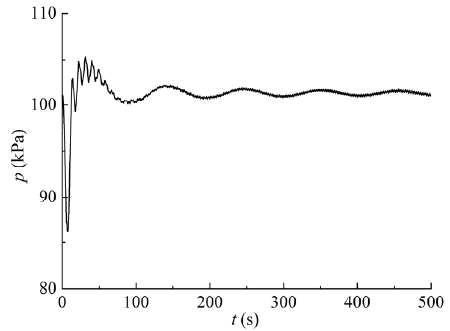
Figure 9. The gas pressure change process of Section J , as simulated by the 1D method.